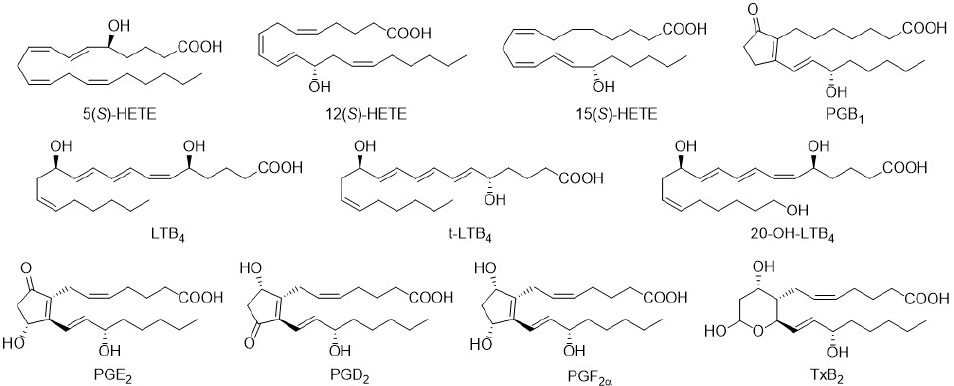
Figure 1. Included eicosanoids in the developed